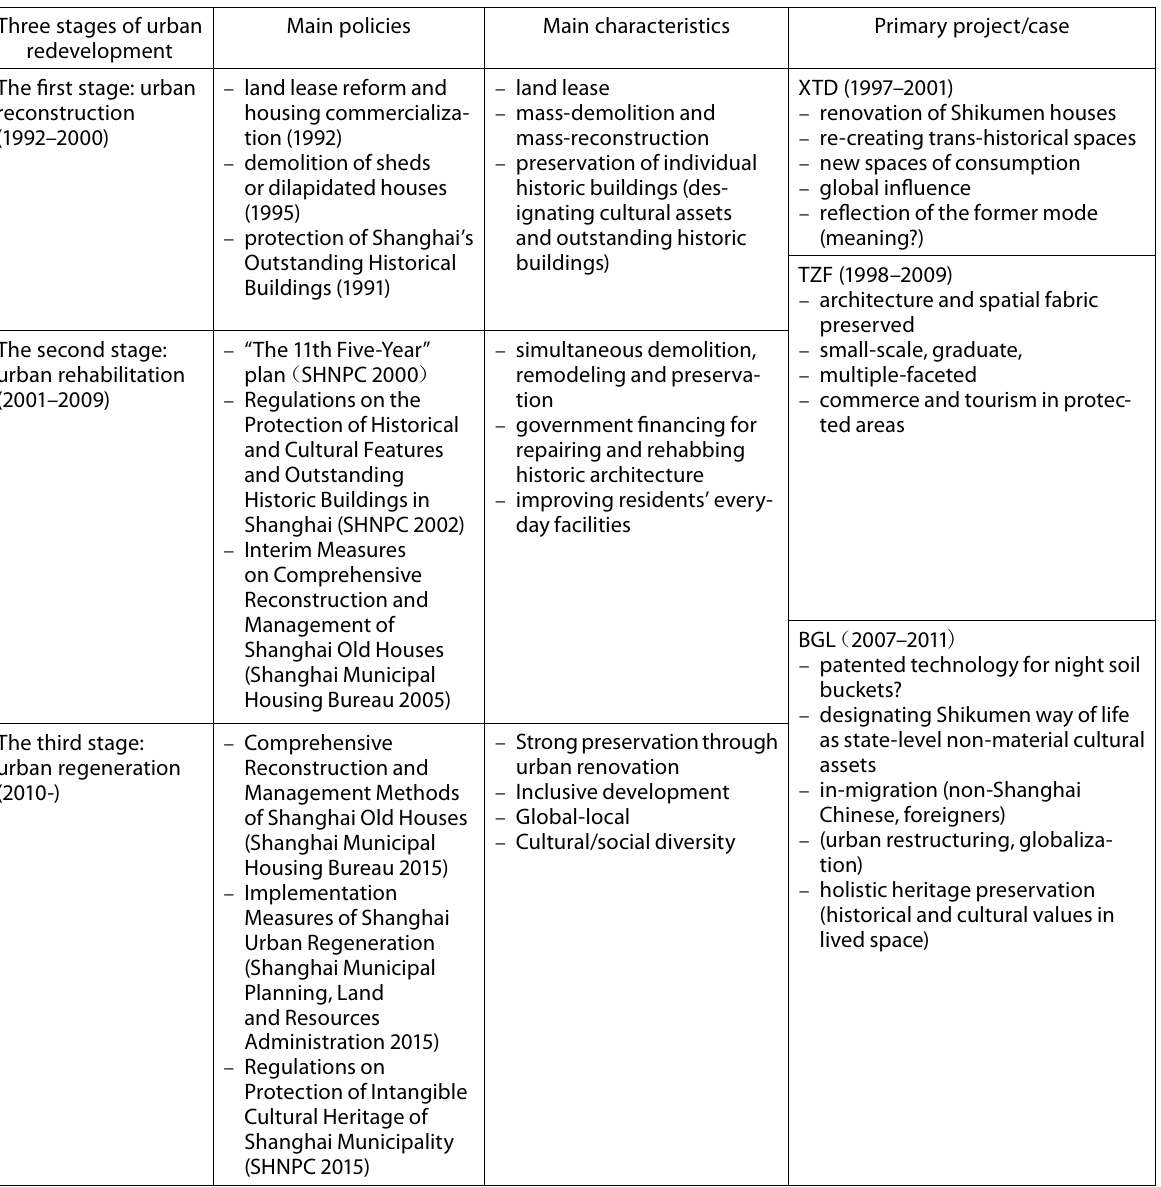
Table 1. a Summary of the three stages and three cases Three stages of urban